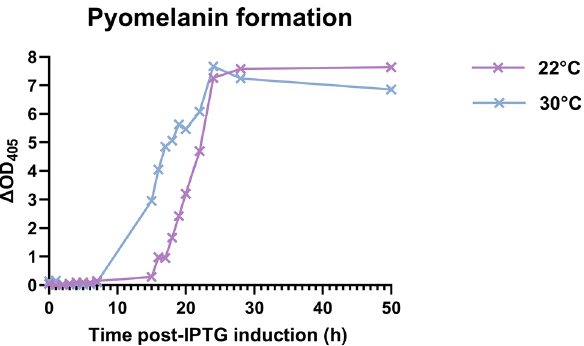
Figure 3. Pyomelanin absorbance measurements (∆OD 405 ~ amount of HGA consumed by HGD) in function of time post-IPTG induction. After 24 h, the auto-oxidation and self-polymerization of HGA into pyomelanin has reached a steady-state for both expression temperatures. To conclude, OD 405 endpoint readouts should be performed at the earliest 24 h after induction with IPTG.